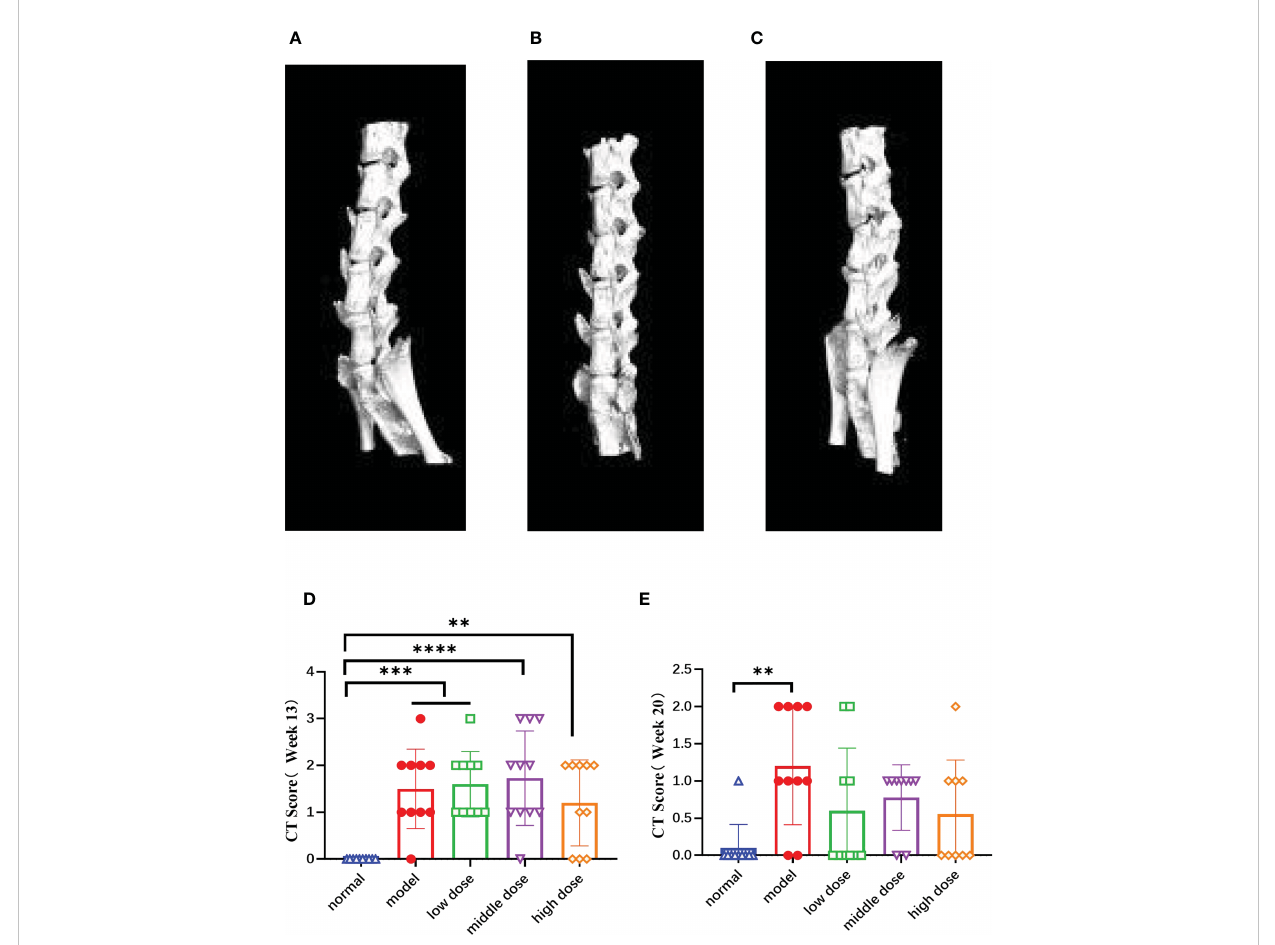
FIGURE 8 The CT images of the mouse spines in each group at the 20th week and score of lesion results referring to BASRI at the 13th week and the 20th week, (A) the CT pictures of the side of normal group; (B) the CT pictures of the side of model group, (C) the CT pictures of the side of hUCMSC treatment group, (D, E) the score of spinal lesions of the mice in each group at the 13th week and 20th week according to the BASRI grading scale. Data are presented as mean ± SD. **p ≤ 0.01 ***p ≤ 0.001 ****p ≤ 0.0001 vs. Normal. In model group, low dose group, middle dose group, n=10; in high dose group,